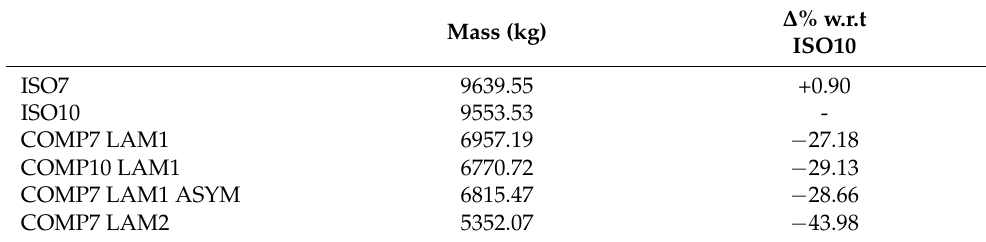
Table 6. Wingbox masses and their variation w.r.t. ISO10 solution for the baseline aircraft.